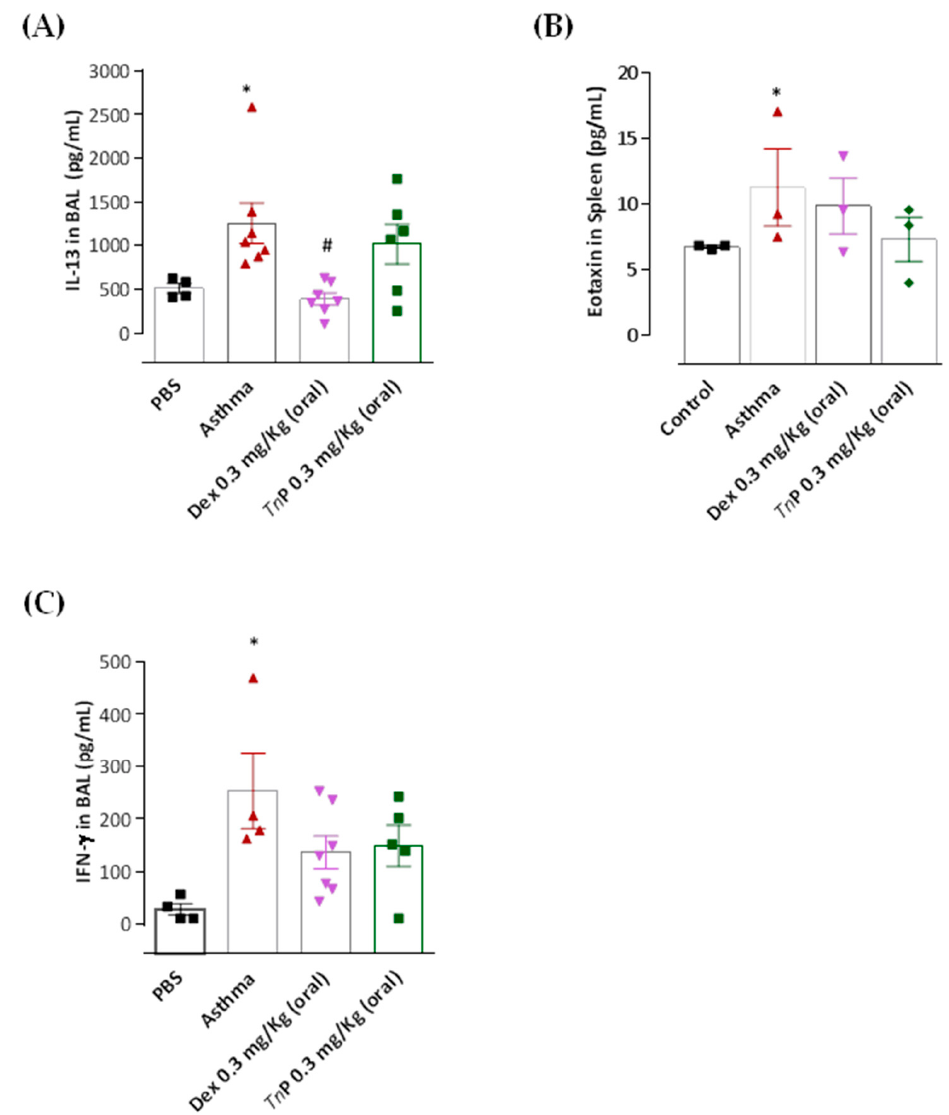
Figure 6. Effect of Tn P on IL-13, eotaxin, and IFN- γ . OVA-sensitized mice subjected to challenge with aerosolized OVA, submitted or not to treatment with Tn P or Dexa, were killed after 24 h for analysis of cytokines by ELISA. The treatment with oral Tn P was not able to reduce IL-13 ( A ), eotaxin ( B ) or IFN- γ ( C ) BAL production. * p < 0.05 compared to the control group and # p < 0.05 compared to the asthma group.